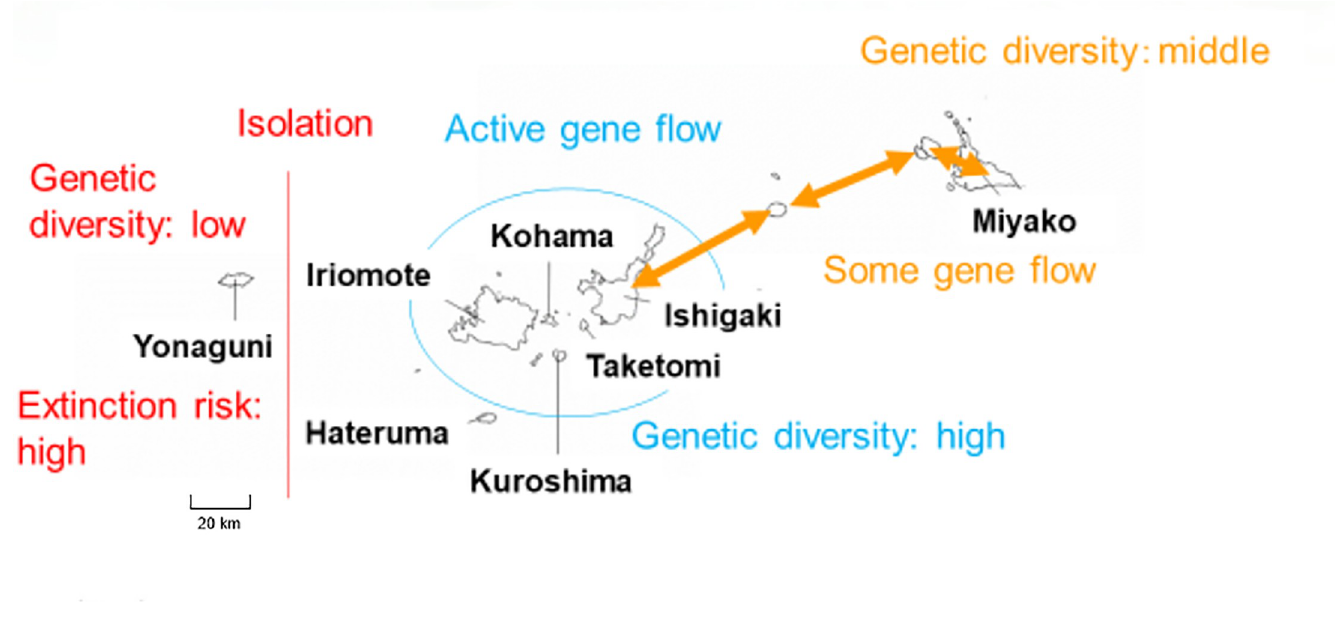
Fig 3. Suggested conservation units. Source of the map was the Geospatial Information Authority of Japan (https://maps.gsi.go.jp).